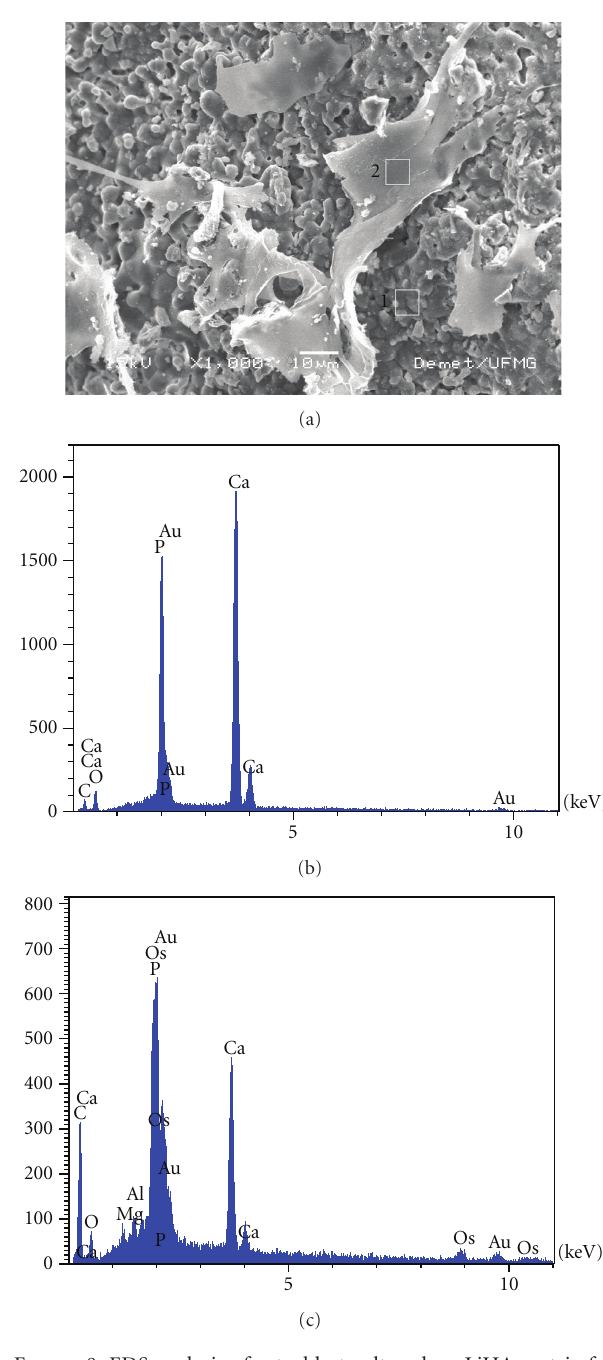
Figure 8: EDS analysis of osteoblast cultured on LiHA matrix for 120 hours. (a) Selected site for EDS analysis. Scale bar: 10 μ m. 1: Analysis performed on the LiHA surface. 2: Analysis performed on the osteoblast